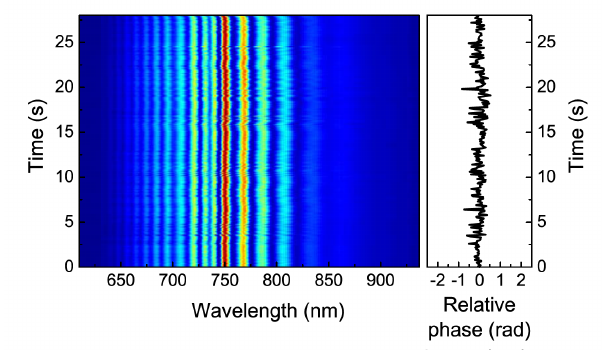
Figure 3. A sequence of interferograms acquired with an f -2 f interferometer over 28 s is reported. In the right panel, the CEP fluctuations are shown corresponding to a rms value of 220 mrad.